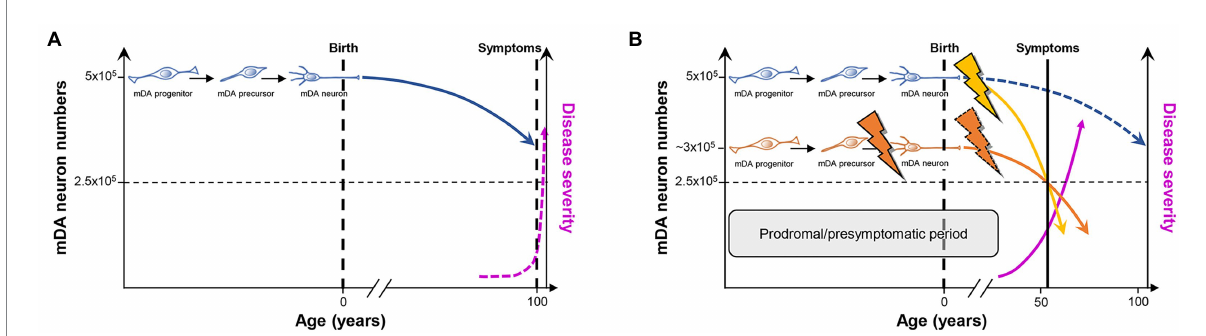
FIGURE 3 PD as a consequence of “multiple hits” or “stochastic acceleration” of an ongoing SNc DA neuron demise throughout the lifetime of a healthy organism. (A) Pre-and perinatal mDA neuron development (indicated by the transition from a proliferating mDA progenitor to a postmitotic mDA precursor to a maturing mDA neuron) endows a healthy human with an average number of 500,000 mDA neurons. Although still debated, a lifelong increased oxidative/nitrosative stress load coupled to a high proteostatic and energetic demand in particularly the SNc DA neurons lead to a continuous demise of some of these neurons (curved blue line) which, however, will not hit the crucial threshold (dashed horizontal black line indicating that only 50% of the mDA neurons remain in the human VM) during the usual human life expectancy. At this threshold, the first PD symptoms would appear (dashed vertical black line), and would worsen with increasing age (dashed pink line). (B) As suggested by the “multiple hit” or “stochastic acceleration” hypotheses, the normal mDA neuron demise (dashed blue line) is accelerated by the impact of diverse genetic and/or environmental stressors throughout the postnatal human lifetime (yellow flash and curved line), and will lead to the appearance of the first symptoms and diagnosis of PD (vertical black line) after reaching the critical threshold of mDA neuron numbers (dashed horizontal black line) in the sixth decade of life, as is the case in most (idiopathic) PD cases. Alternatively or in addition, a faulty pre-/perinatal mDA neuron development (orange flash) will render the individual with an already reduced number of mDA neurons at birth, which is still above the critical threshold and can thus be compensated by a heightened DA signaling and metabolism in the remaining mDA neurons from the human VM. Nevertheless, the normal age-related demise of these neurons, most likely together with additional postnatal impacts including a compromised mDA survival (dashed orange flash), will also lead to a much earlier surpassing of the critical threshold and diagnosis of PD (curved orange line). In both cases and due to the current lack of disease-modifying or-halting treatments, PD symptoms and thus severity of the disease will progressively worsen (pink line). The prodromal and presymptomatic period of life in these individuals (gray box) probably represents the best window of opportunity for the modification or, ideally, prevention of PD. Modified after (Le et al., 2009; Collier et al., 2011; Von Linstow et al.,